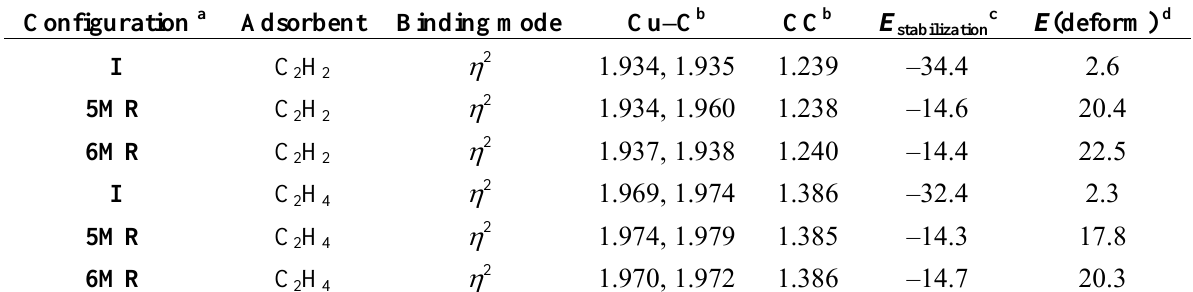
Table 4. Key parameters of the optimized structures for an unsaturated hydrocarbon adsorbed on a dicopper active center embedded inside a realistic ZSM-5